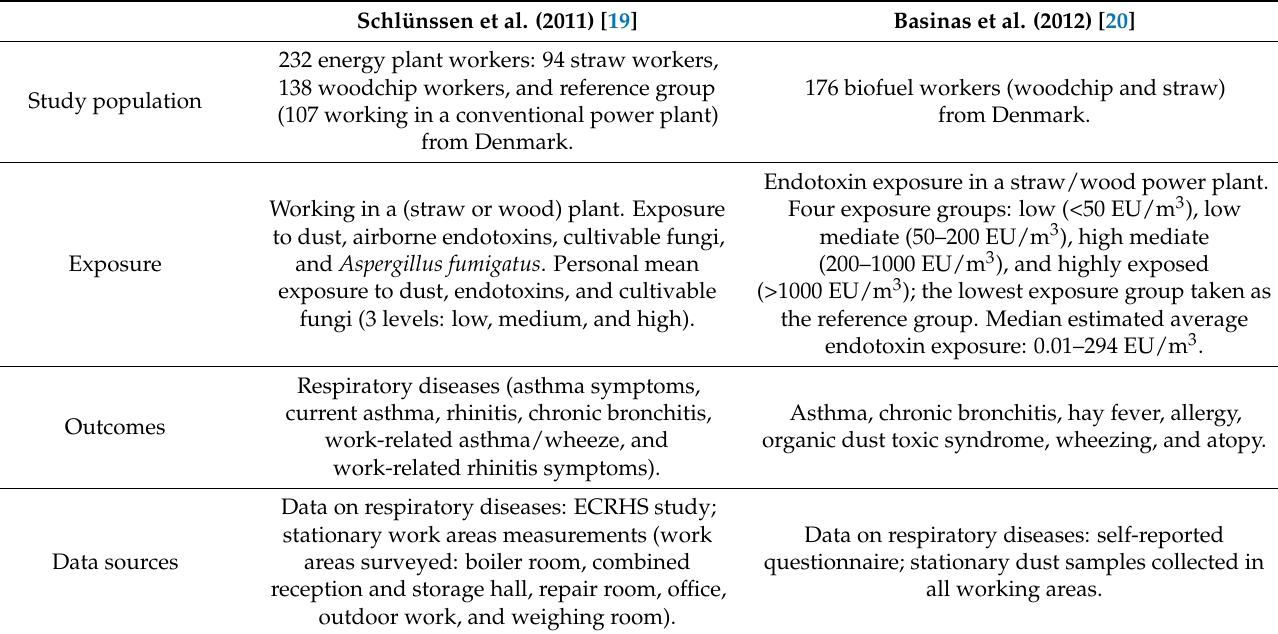
Table 3. Main features of the included epidemiological studies in occupational settings. Schlünssen et al. (2011) [19] Basinas et al. (2012) [20]